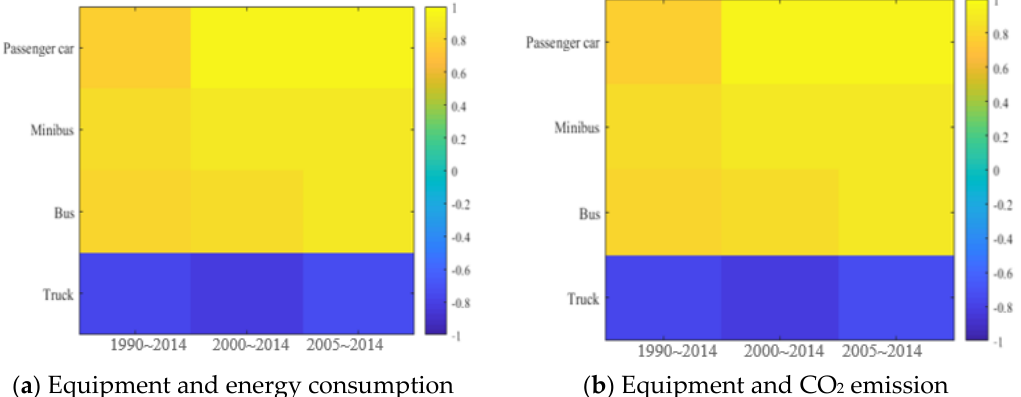
Figure 10. Correlation between equipment energy efficiency improvement, energy consumption and CO 2 emission of transportation in different stages (( a ) with energy consumption and ( b ) with CO 2 emission).